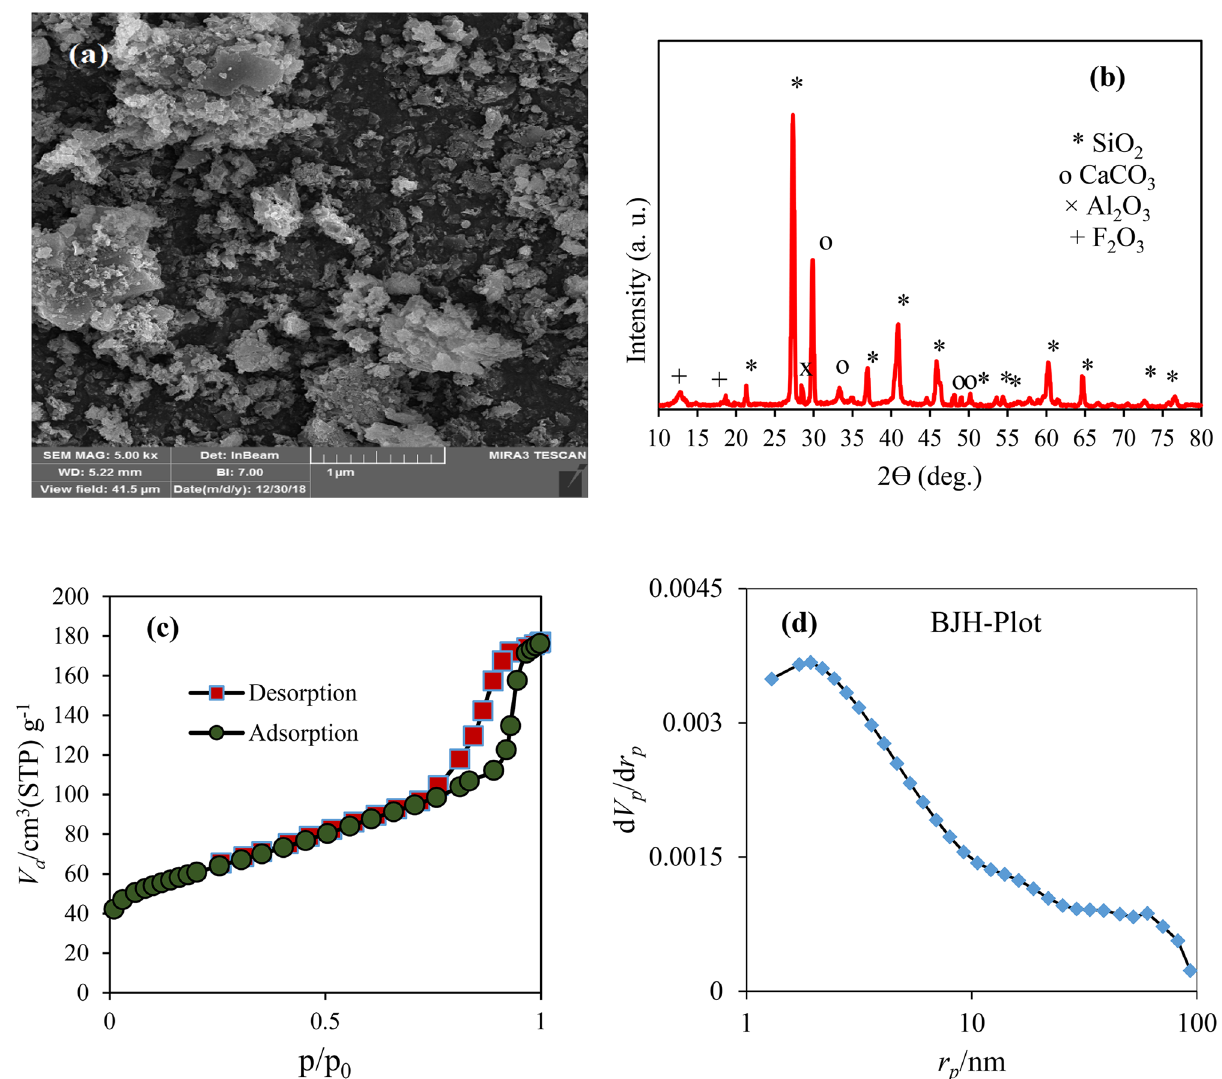
Figure 1. SEM ( a ), XRD ( b ), BET ( c ) and BJH analyses for